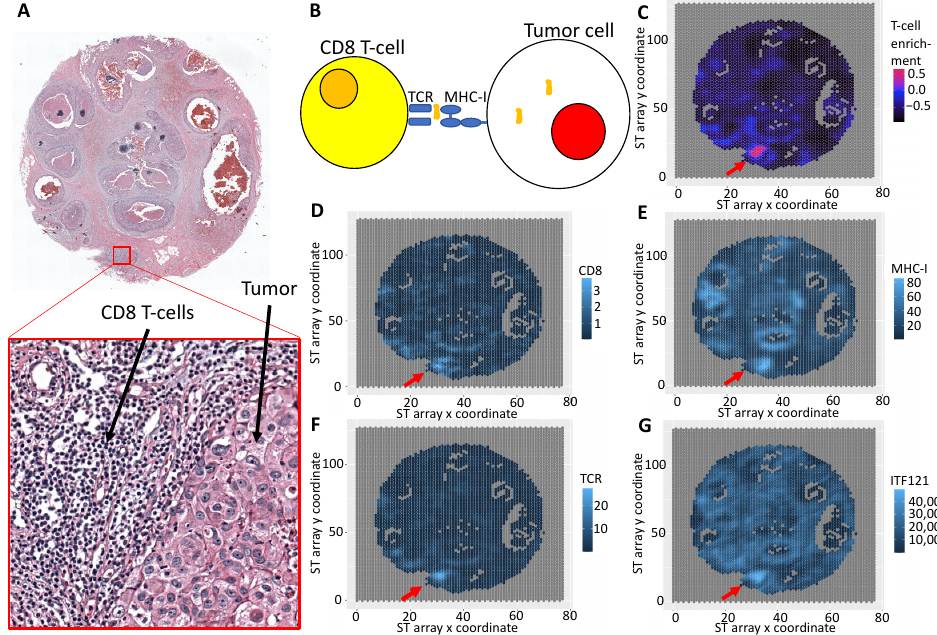
Figure 4. ITFs associated with cellular signaling. Here, 1-dimensional ITF121 is associated with CD8 T-cell interaction with tumor regions likely through MHC-I. Note that the periphery of the tumor region has greater ITF121. ( A ) H&E pathology image from an ST array. ( B ) Simplified diagram of T-cell and tumor signaling via MHC-I. ( C ) T-cell enrichment using DEGAS. Expression of marker genes ( D ) CD8, ( E ) MHC-I (HLA-C), and ( F ) TCR (TRAC). ( G ) ITF121 was calculated for an image patch around each ST spot. Red arrows indicate region enriched for CD8 T-cells interacting with the tumor.